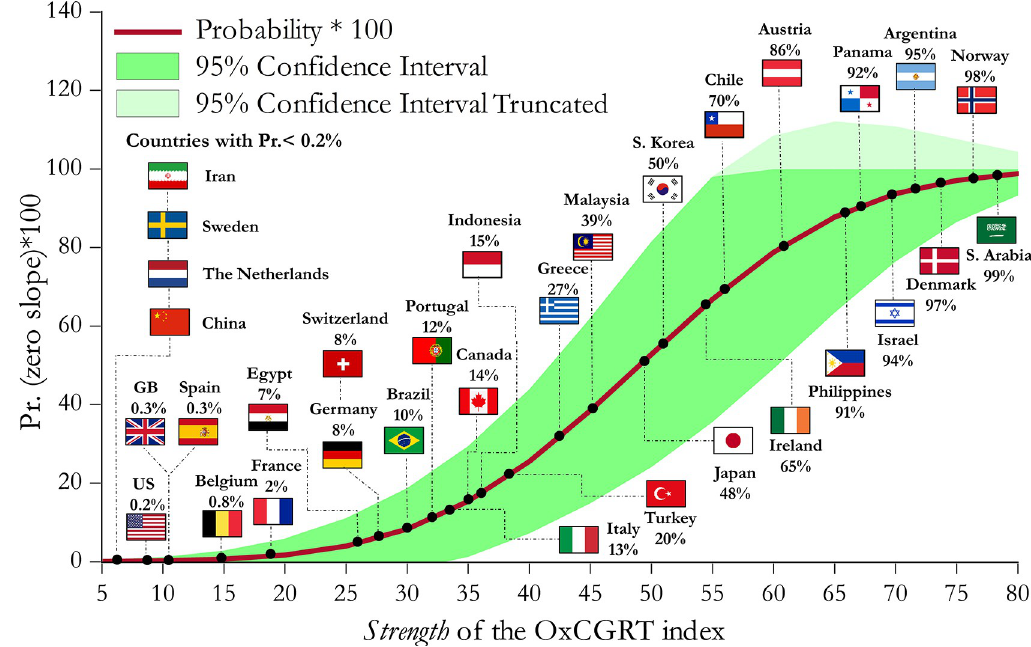
Fig 4. OxCGRT index strength at t � and probability of insignificant increasing